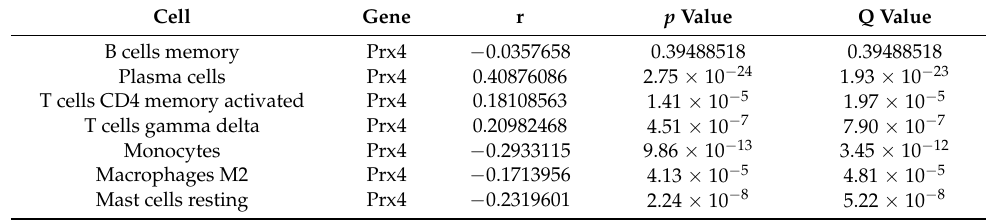
Figure 5. PRDX4 regulates tumor immune microenvironment in LUAD. ( A ) Gene association with PRDX4 in LUAD. ( B , C ) The 22 infiltrated immune cells in LUAD and normal tissues. ( D ) The 22 infiltrated immune cells in the PRX4 high/low expression LUAD groups. ( E ) Correlation between PRDX4 and the seven differential immune cells, (*, p < 0.05). Table 2. The correlation between PRDX4 and the seven differential immune